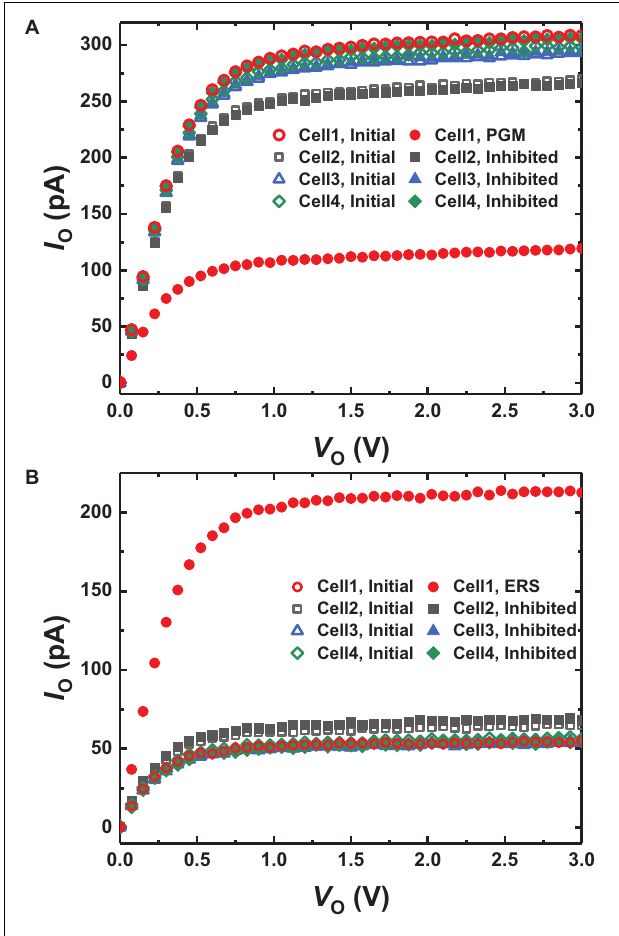
FIGURE 5 | I O - V O curves of the GSDs in the array (A) programming for 10 ms and (B) erasing for 100 ms depending on each condition in Figure 4 . Only the current of cell 1 is changed, while others are inhibited successfully.